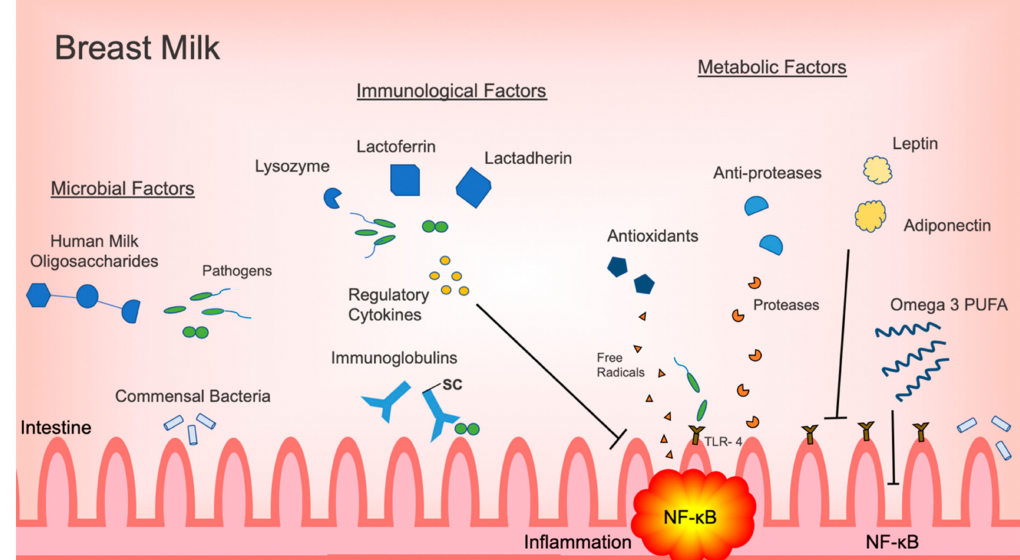
Figure 1. Summary of microbiologic, immunological and metabolic factors in breast milk with e ff ects on regulating intestinal inflammation. Abbreviations: secretory component (SC); Toll-like receptor 4 (TLR4); nuclear factor kappa B (NF- κ B); polyunsaturated fatty acid